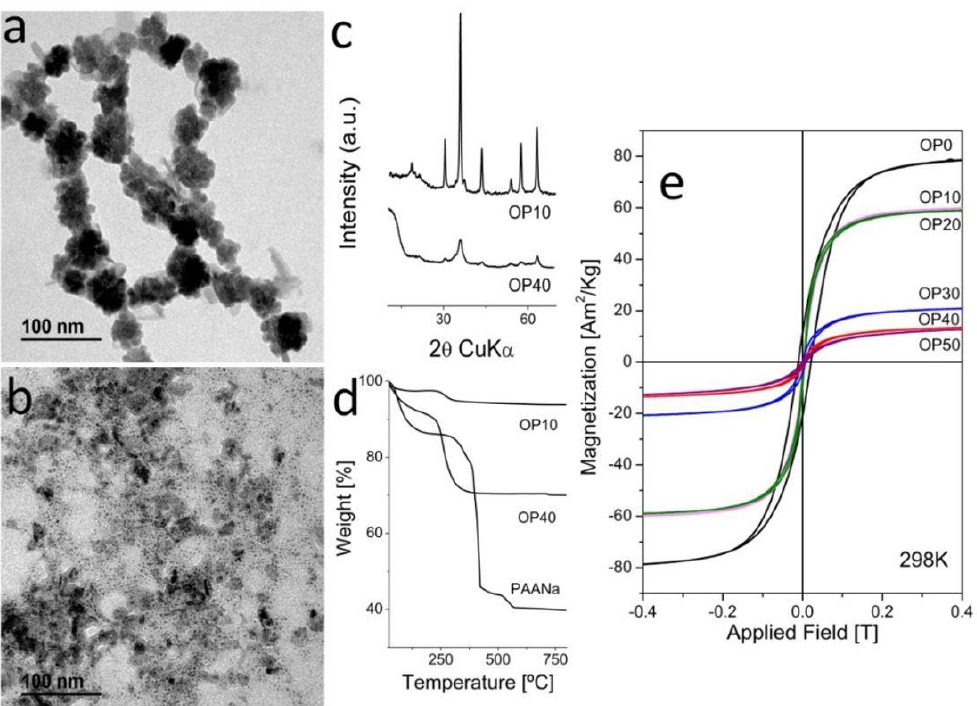
Figure 2. Characterization of MNCs produced by oxidative precipitation in one step. ( a , b ) TEM micrograph of OP10 and OP40; ( c ) Comparative XRD of samples of OP10 and OP40; ( d ) Comparative TG of samples of C10, C40, and pure poly(sodium acrylate (PAANa); ( e ) Hysteresis cycles at room temperature.